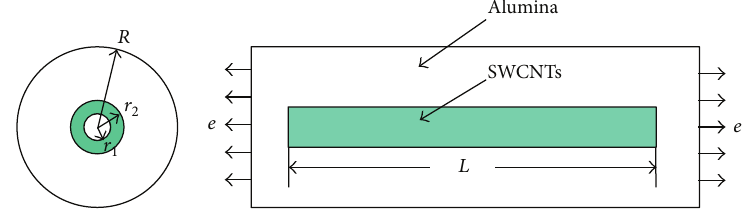
Figure 5: The RVE of SWCNTs reinforcement alumina composites.